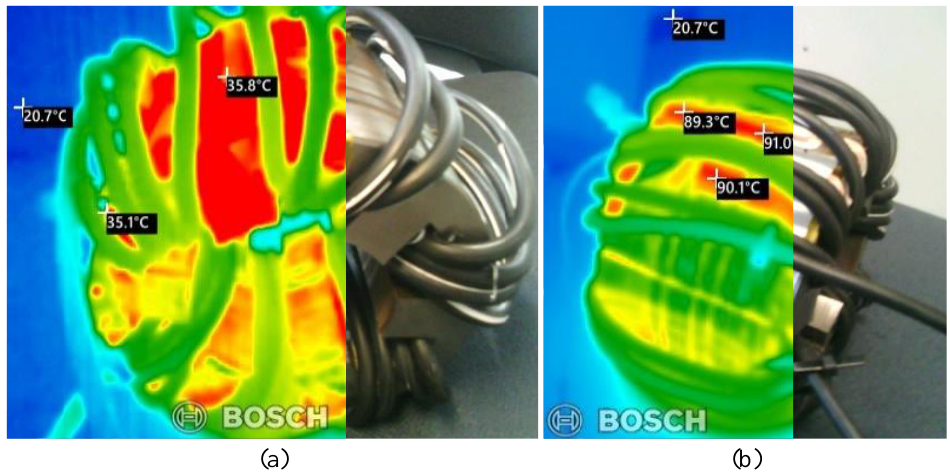
Figure 16. Thermal images of the core losses at low and high frequencies at the same magnetic induction B = 1 T. ( a ) 100 Hz. ( b ) 1 kHz.